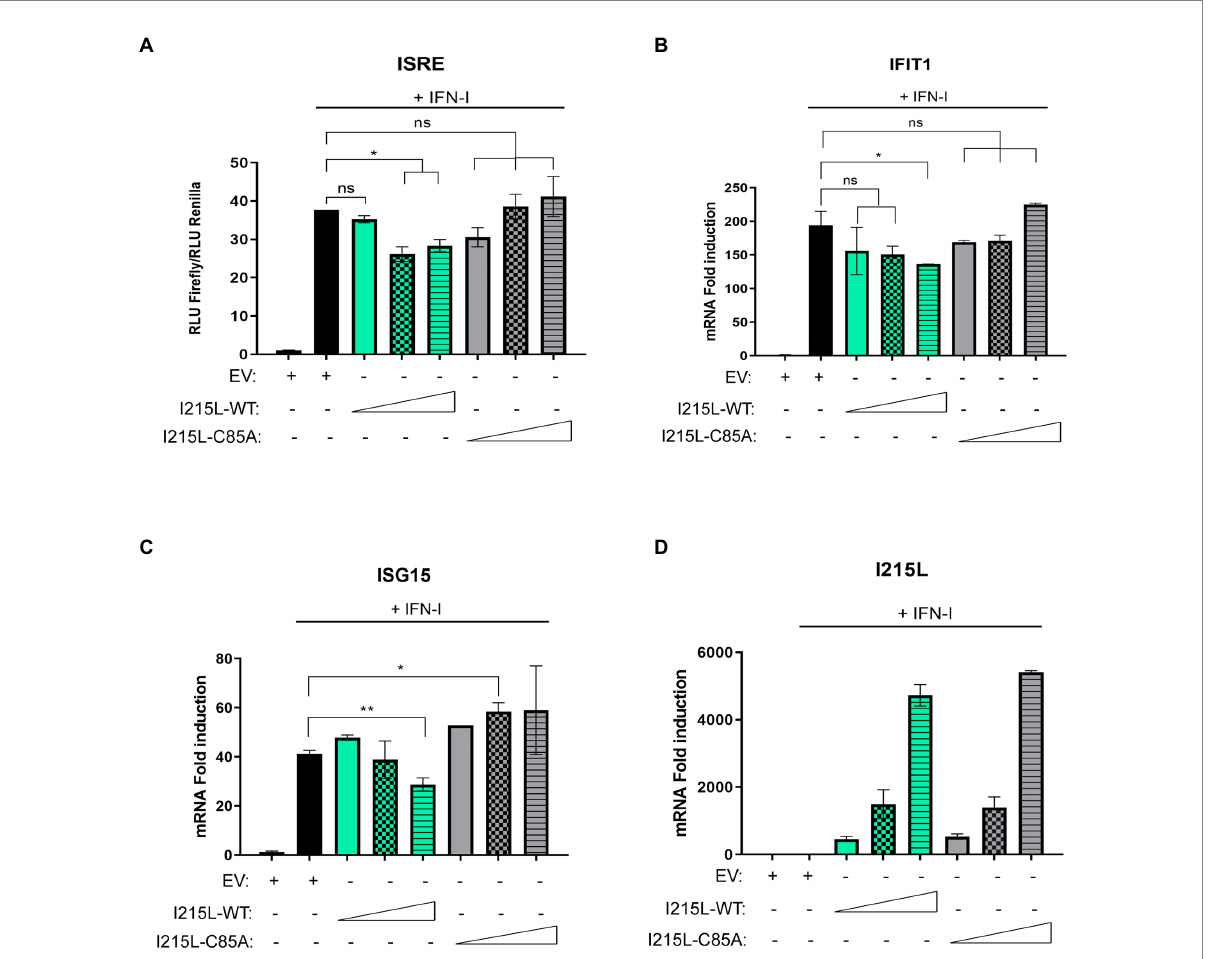
FIGURE 4 pI215L-dependent inhibition of IFN-I-mediated signaling pathway relies on its ubiquitin-conjugating activity. (A) ISRE-luciferase reporter experiment was performed in HEK-293 cells transfected with EV or with increasing concentrations of either pIRES-I215L-WT-myc or pIRES-I215L- C85A-myc (0.3, 1, or 3 μ g/1 × 10 6 cells) in absence or in presence of IFN-I (500 U/mL). Graph represents the means of the Firefly luciferase RLU (Relative Luminiscence Units) values divided by its Renilla luciferase RLU values from biological triplicates. Obtained values were relativized against the untreated EV transfected sample. (B) IFIT1 and (C) ISG15 mRNA levels were analyzed in COS-1 cells transfected with EV (2.5 μ g/1 × 10 6 cells) or increasing concentrations of pIRES-I215L-WT-myc or pIRES-I215L-C85A-myc (0.25, 1, or 2.5 μ g/1 × 10 6 cells) by qRT-PCR. (D) As a control of I215L transfection, I215L mRNA levels were also amplified by qRT-PCR in the same conditions than A-C. All data reflect mean ± SEM ( n = 3). Data were statistically analyzed by using a Student t test (* p < 0.05; ** p < 0.01; ns: not